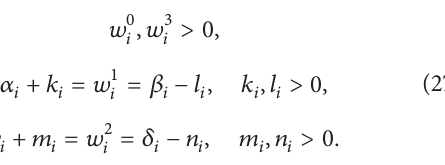
Figure 9: Rational cubic trigonometric curve lying below the given